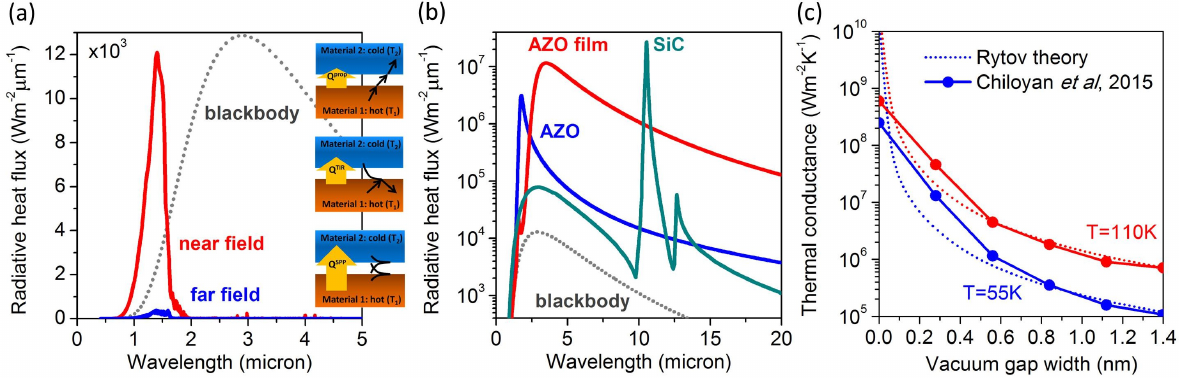
Fig. 10. Near-field effects in the enhancement of the radiative heat transfer. (a) Spectral radiative heat flux between a thin-film “thermal well” emitter and a thin-film absorber [105] in both near-field (10 nm vacuum gap, solid red line) and far-field (100 micron vacuum gap, solid blue line) regimes with respect to a blackbody heat flux at the same temperature (gray dotted line). The emitter is a Ge thin-film of 860 nm thickness and an absorber is a GaSb film of 136-nm thickness, both of which are supported by perfect back reflectors [105]. The hot and cold side temperatures are 1000 K and 300 K, respectively. The insets schematically illustrates the three channels used for the radiative heat transfer, from top to bottom: via propagating waves, via photon tunneling due to frustrated total internal reflection, and via near-field coupling of high-LDOS surface polariton modes. (b) The heat flux spectra as a function of wavelength between various emitters and absorbers supporting surface polariton modes. The gap is 20 nm wide, and the hot and cold side temperatures are 1000 K and 360 K, respectively. The blackbody heat flux is shown as the dotted line. (c) Thermal conductance as a function of gap width calculated by using the classical (Rytov) theory [7, 8] and a recently developed atomic approach